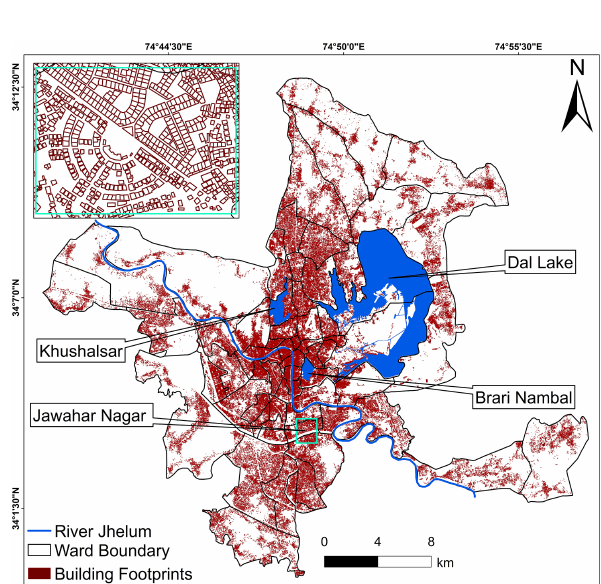
Figure 3. Building footprint map of